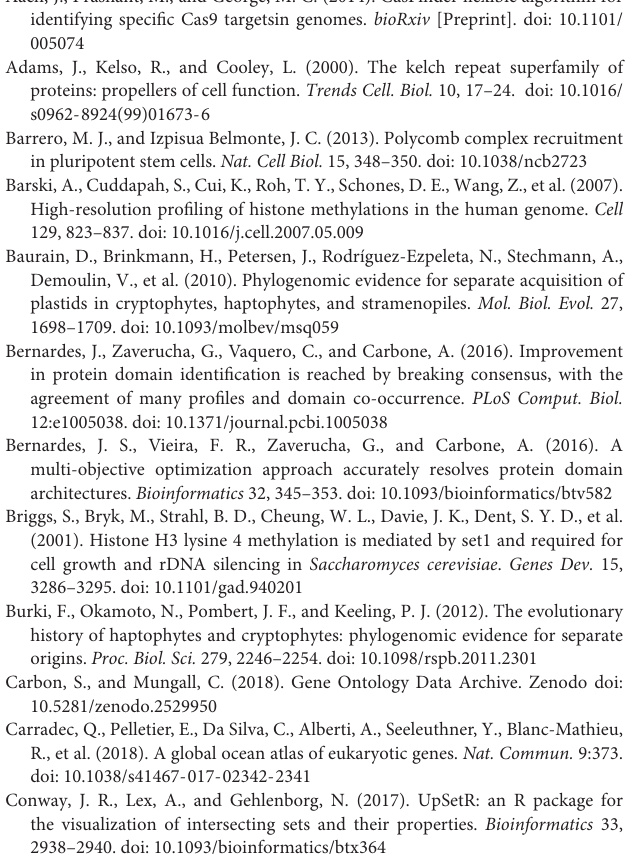
10–90% of data and the outliers are shown as whiskers. Median of the data is shown in a small dot in the center of the box ( t -test: p -value = 1.581e-08). FIGURE S3 | H3K4me3 Correlation plot. Pairwise scatterplots showing correlation of the two H3K4me3 ChIP-seq replicates. Genome is split into bins and enrichment scores per bin were calculated. Pearson correlation coefficient for the comparison of enrichment scores is marked. FIGURE S4 | PTMs distribution. Upper panel shows average ChIPseq profile (read density) over TSS of genes. Lower panel shows heatmaps of ChIPseq data of individual histone modifications and input is shown over TSS. TABLE S1 | Reference sequences used in this study. TABLE S2 | List of species found in MMETSP with PRC1 or/and PRC2 components and Trithorax components. The table contains species have at least one PcG proteins with present or absent of TrxG protein which located at the last column. TrxG column also specify the trithorax homologs clade classification which is discussed in this paper, species with both PcG catalytic enzyme (E(z) and RING/Psc) and TrxG were highlight in yellow background. TABLE S3 | Protein sequences of PRC1, PRC2 and TrxG components. The table shows the PFAM domains, their coordinates within the sequences and score. TABLE S4 | Gene annotations and functional categories of histone marked genes in P. tricornutum . Genes annotated for each histone modification are summarized and tabulated. Histone marked genes are given value 1 and unmarked genes in the genome are given value